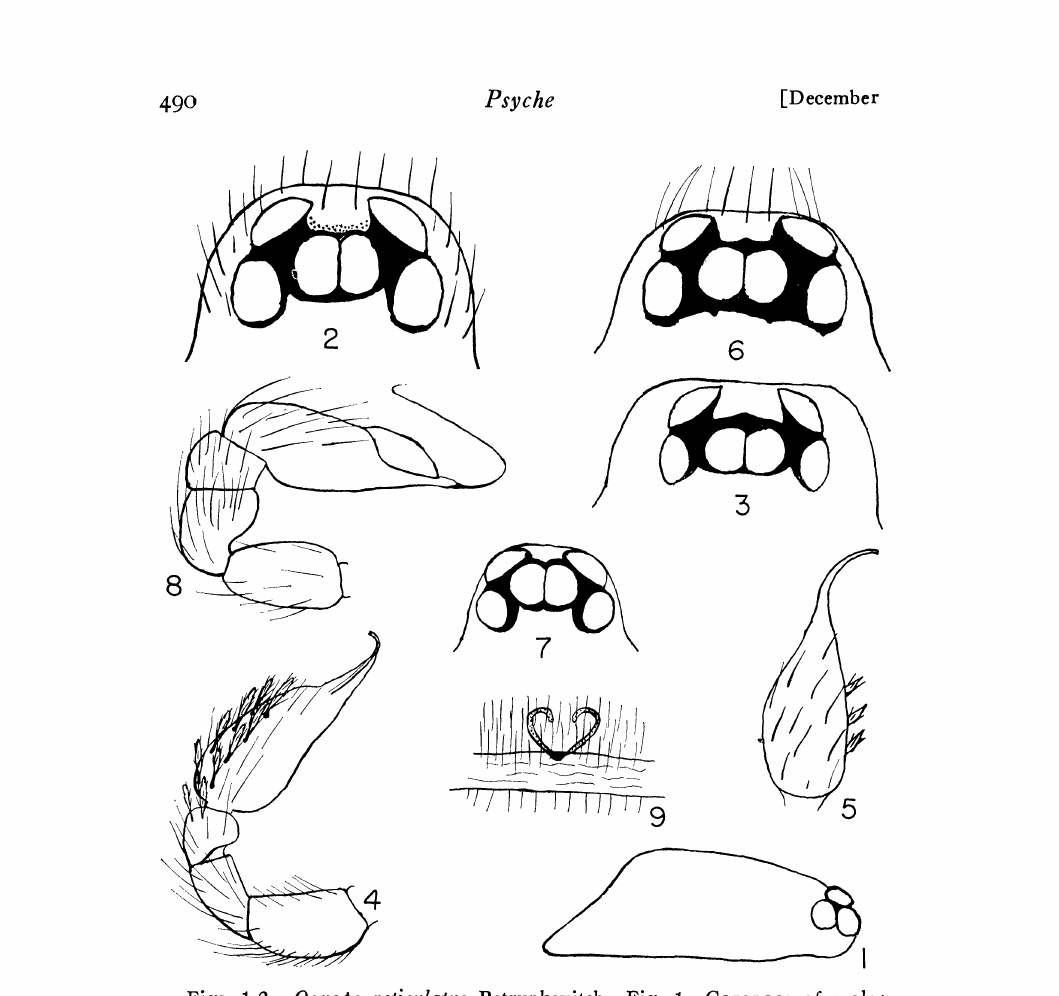
Figs. 1-2. Oonops reticulatus Petrunkevitch. Fig. 1. Carapace of male; right lateral side. Fig. 2. Eyes of female from above. Figs. 3-6. Oonops ornatus sp. nov. Fig. 3. Eyes of male from above. Fig. 4. Left palp of male holotype; prolateral view. Fig. 5. Left palpal tarsus of holotype; dorsal view. Fig. 6. Eyes of female from above. Figs. 7-9. Oonops tectulus sp. nov. Fig. 7. Eyes of male holotype from above. Fig. 8. Left palp o,f male holotype; prolateral view. Fig. 9. Epigynal area of described female paratype from